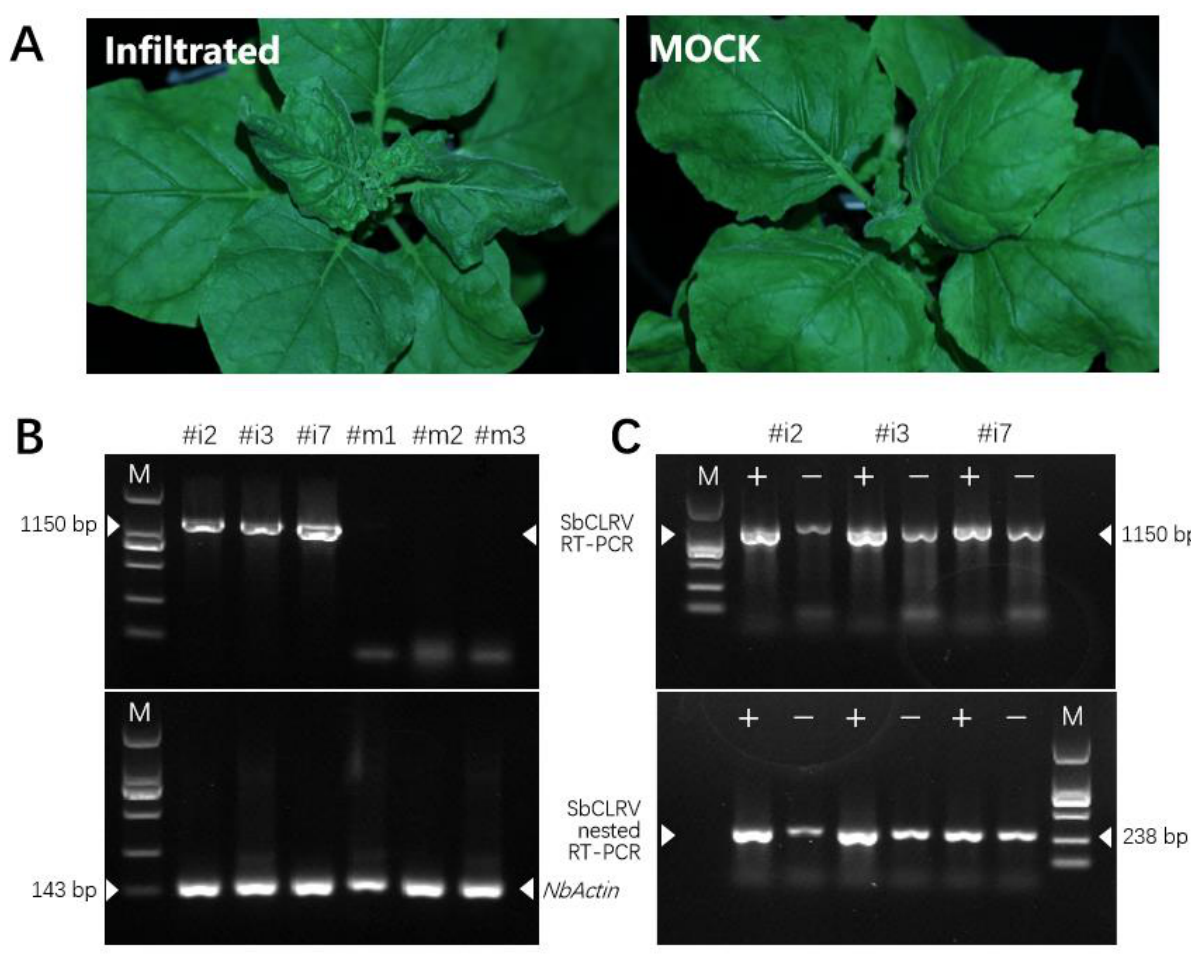
Figure 3. Symptoms on leaves of Nicotiana benthamiana infected by soybean chlorotic leafroll virus (SbCLRV) and virus detection. ( A ) Chlorosis and leafroll symptoms on upper leaves of N. Benthamiana inoculated by SbCLRV. Pictures were taken at 10 dpi; ( B ) RT-PCR detection of the symptomatic leaves (line 1, 2, 3) and mock-inoculated leaves (line 4, 5, 6) at 15 dpi; ( C ) detection of replicating SbCLRV by strand-specific RT-PCR and seminested RT-PCR. “+” and “ − ” represent the positive-strand-specific RT-PCR, and negative-strand-specific RT-PCR, respectively.